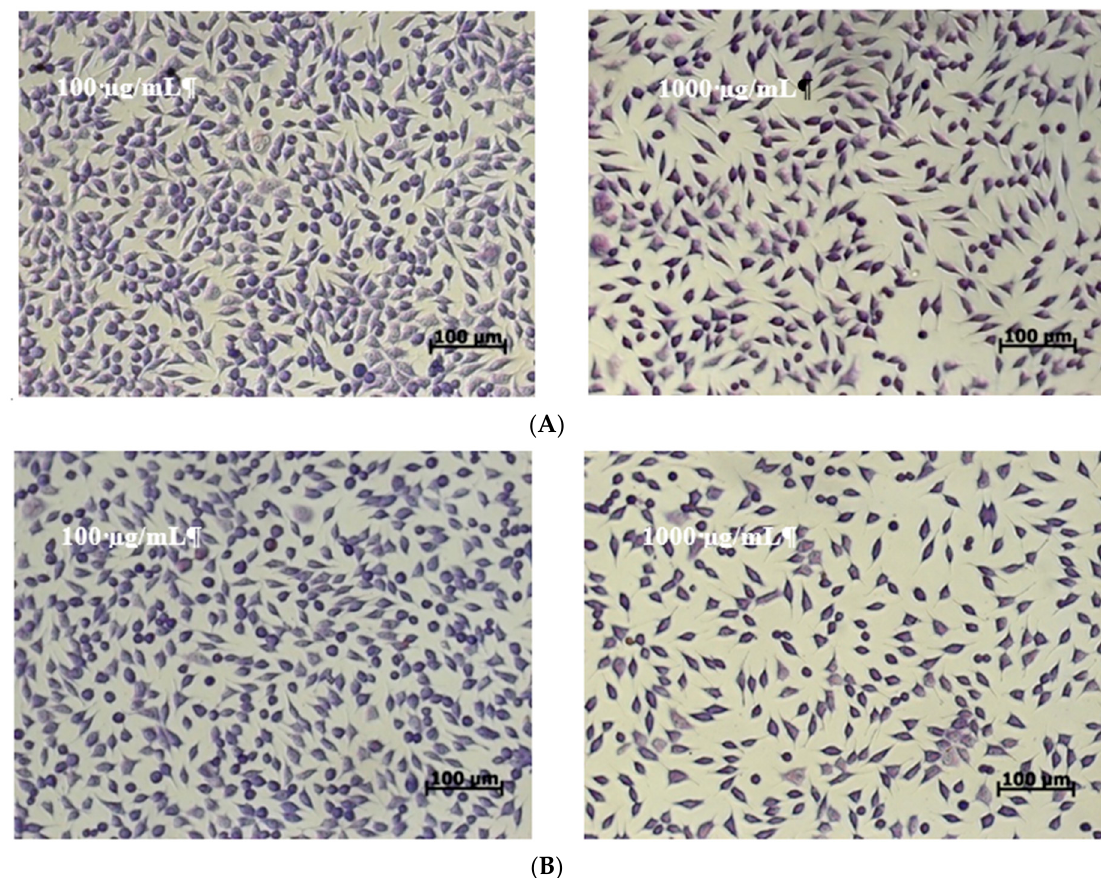
Figure 4. Light micrographs of L929 cells treated with microencapsulated powders: ( A ) variant 1 and ( B ) variant 2 for 48 h.